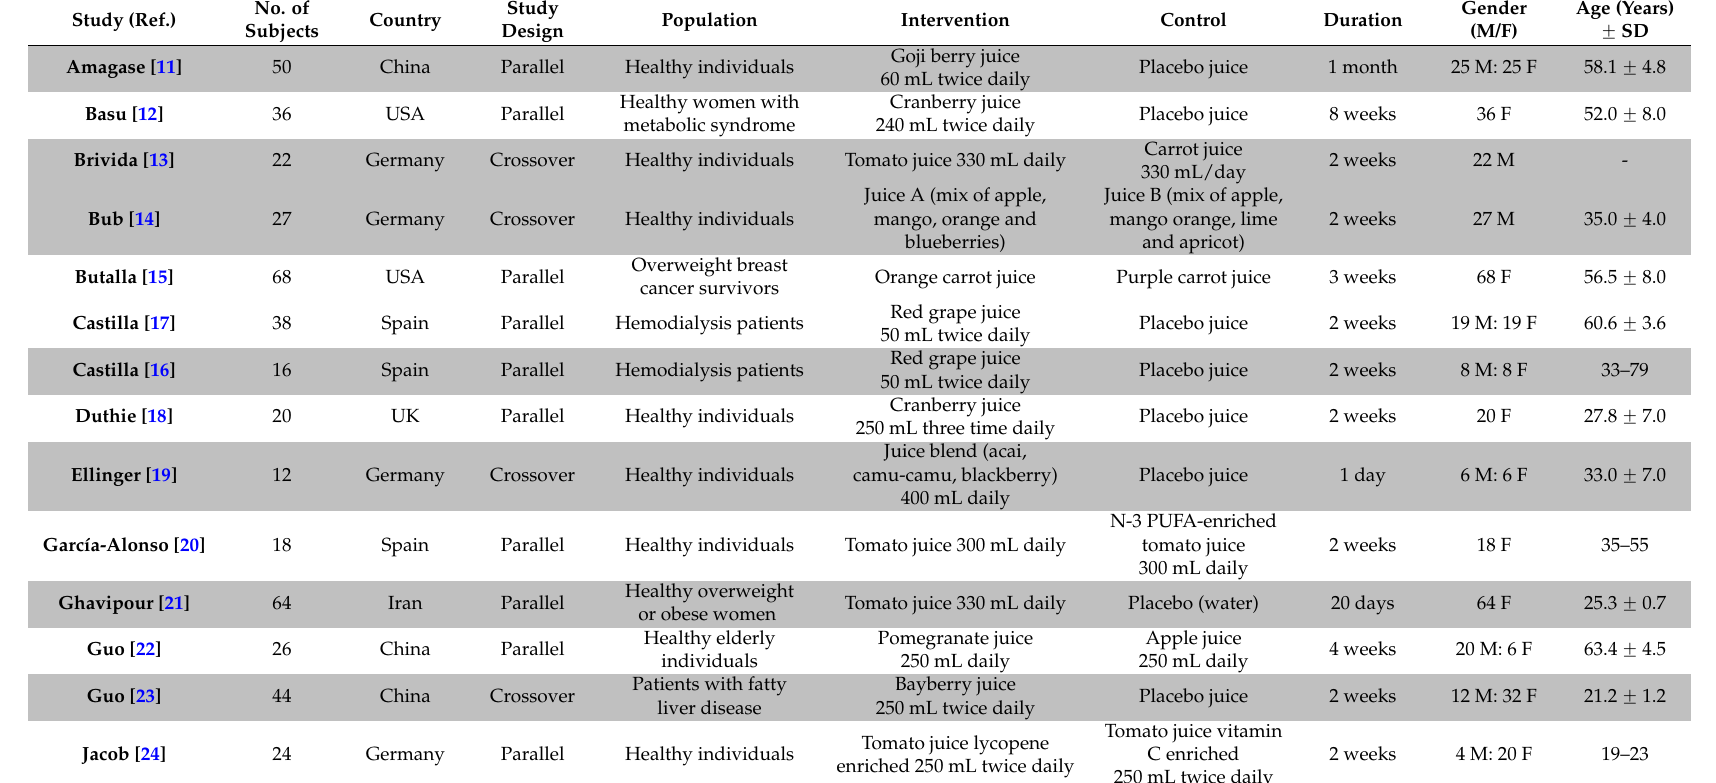
Table 1. Characteristics of included